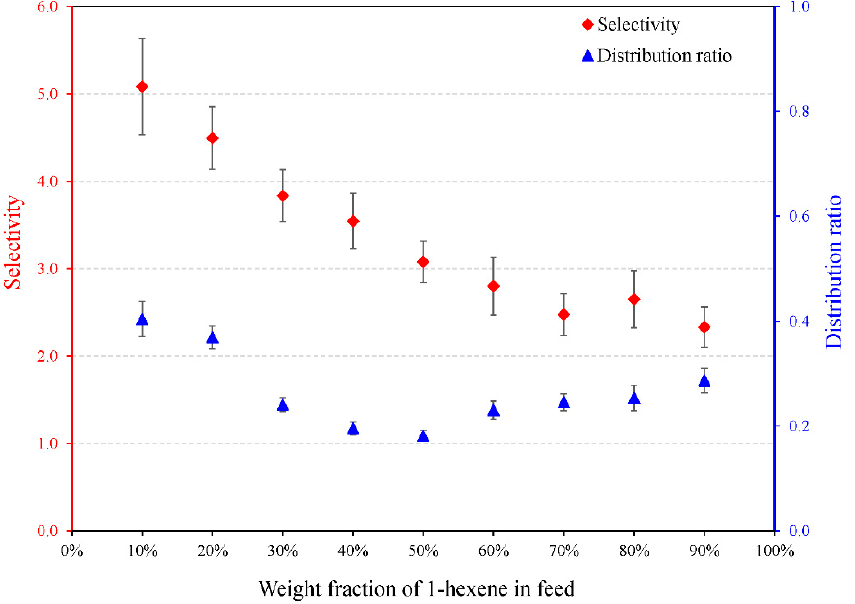
Figure 7. Variation of the selectivity and the distribution ratio with toluene weight fraction in the feed for {1-hexene (1) + toluene (2) + DES #3 (3)}. feed for {1-hexene (1) + toluene (2) + DES #3